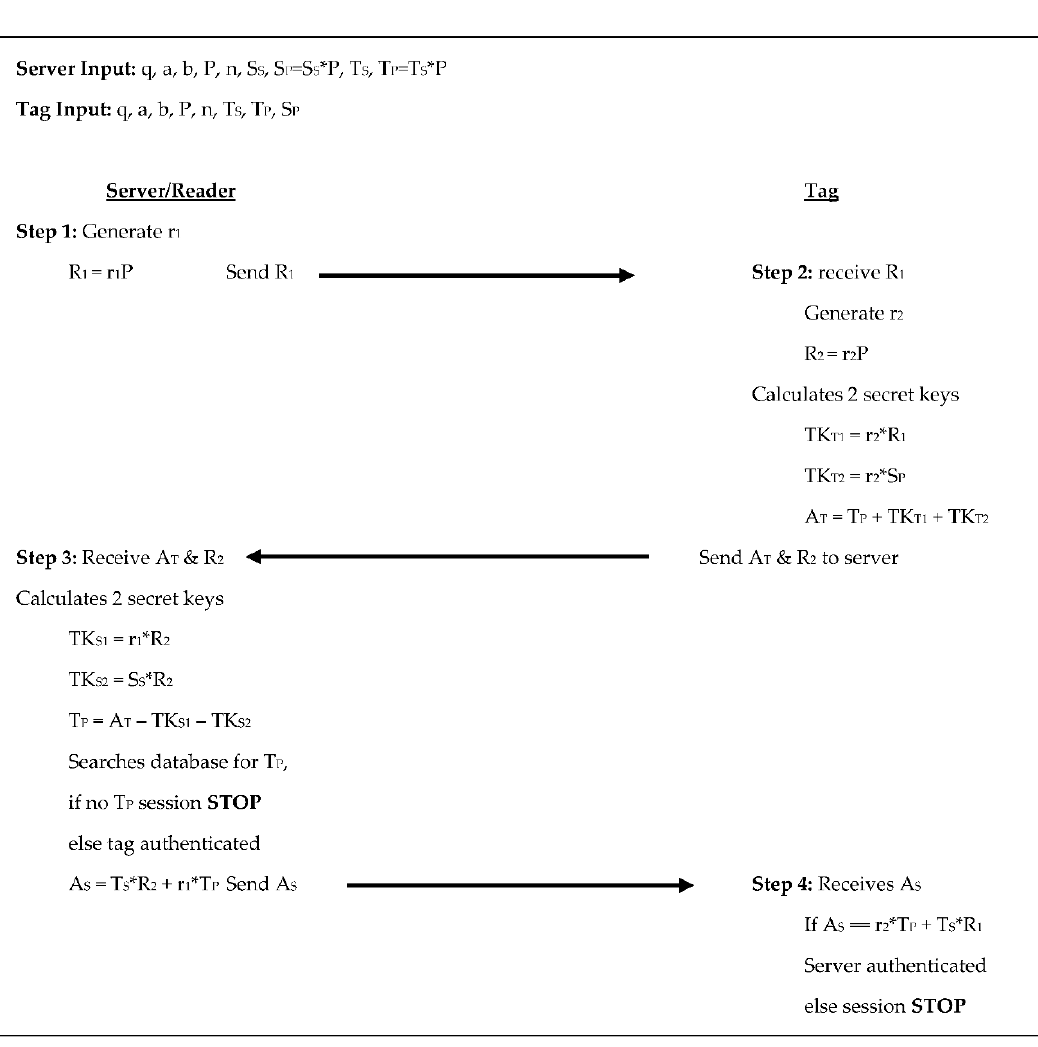
Figure 3. Authentication phases for Liao et al. [18].